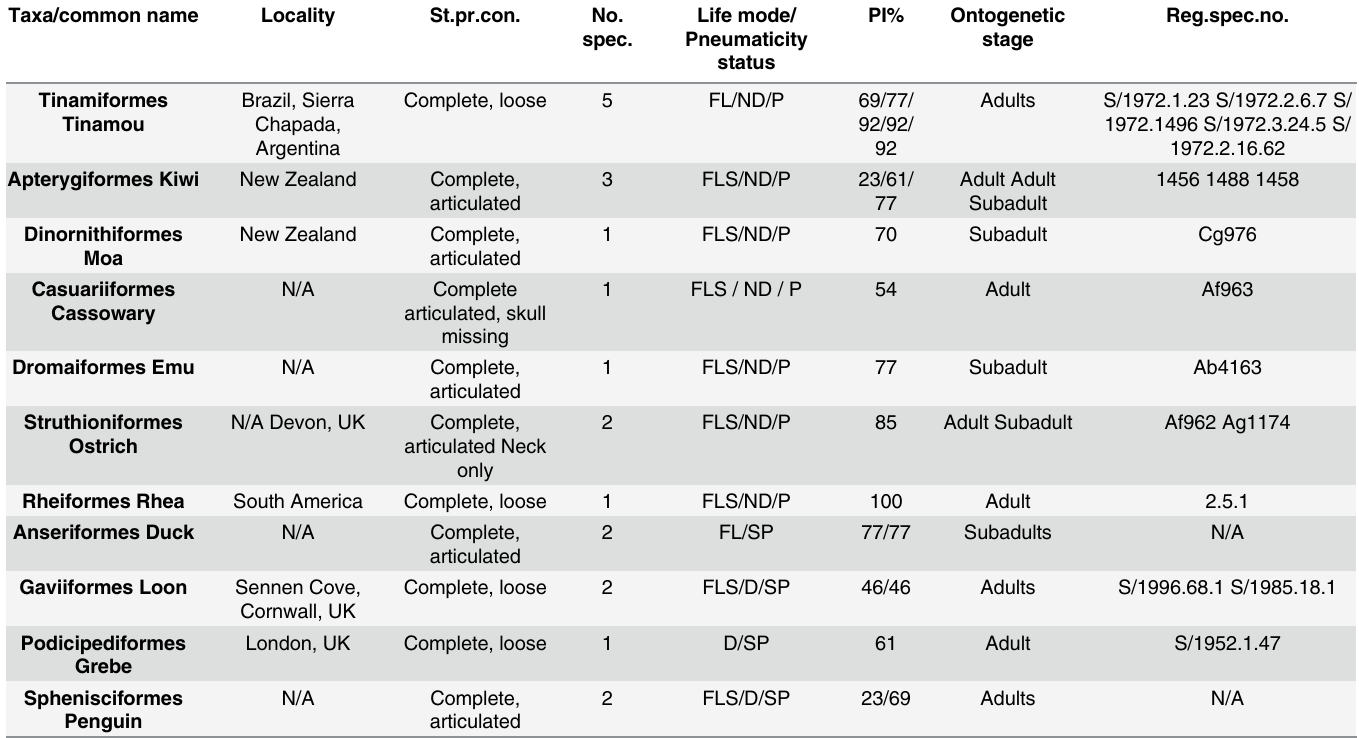
Table 1. General status of each avian taxon studied. Tabulation of bird taxa with their orders, indicating locality, state of preservational condition of the specimen (St.pr.con.), number of specimens, pneumaticity status, Pneumaticity Index (PI%), ontogenetic stage, and registered specimen number (Reg.sp. no.). Abbreviations: D, diver; FL, flyer; FLS, flightless; ND, non-diver; P, pneumatic; SP,